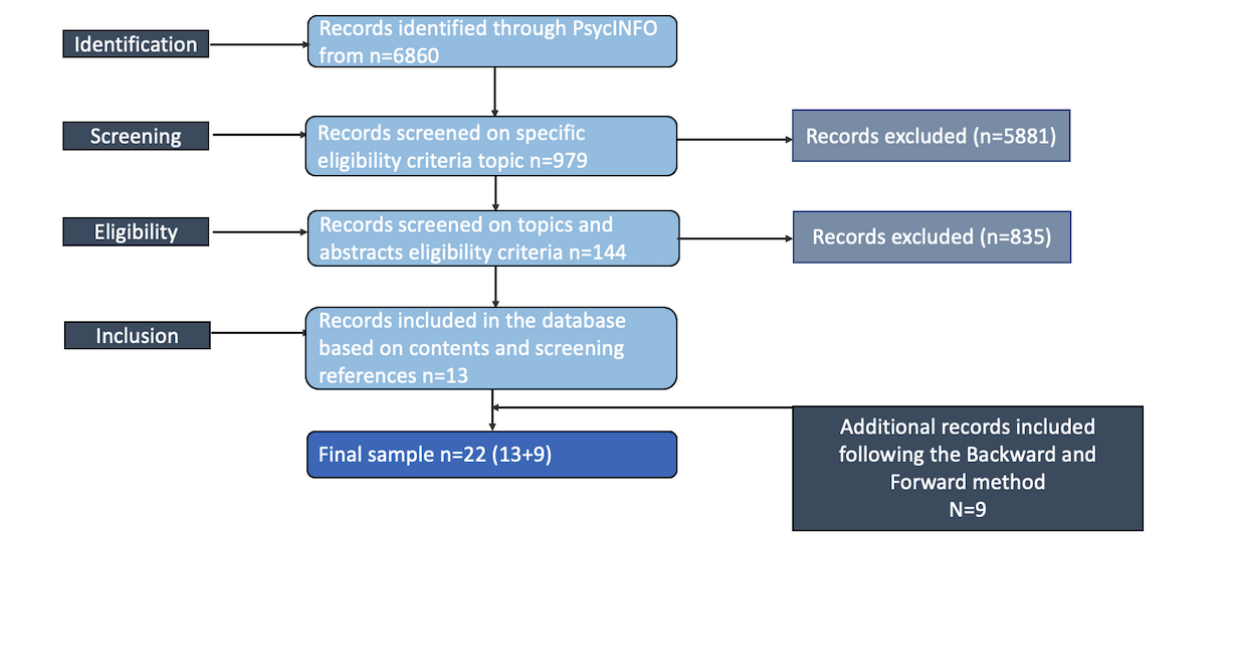
Figure 2. Flowchart. Selection of